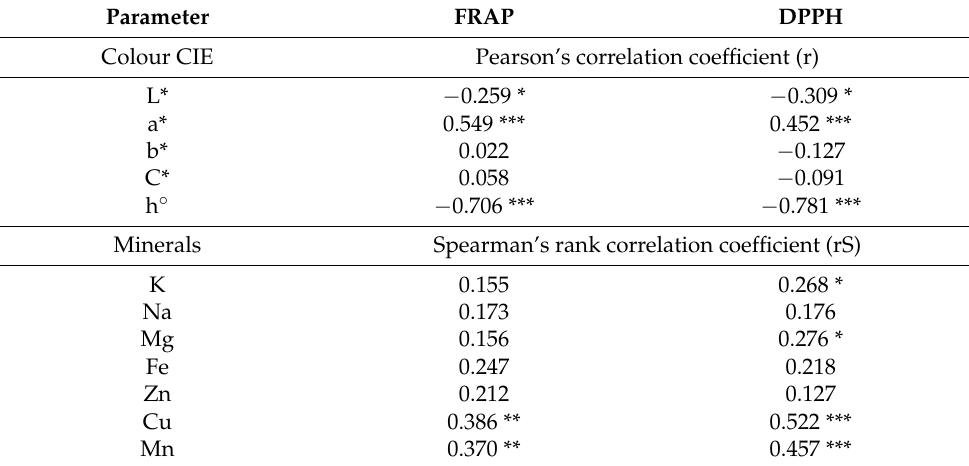
Table 2. Correlations between antioxidant activity and colour parameters and minerals. Parameter FRAP DPPH Colour CIE Pearson’s correlation coefficient